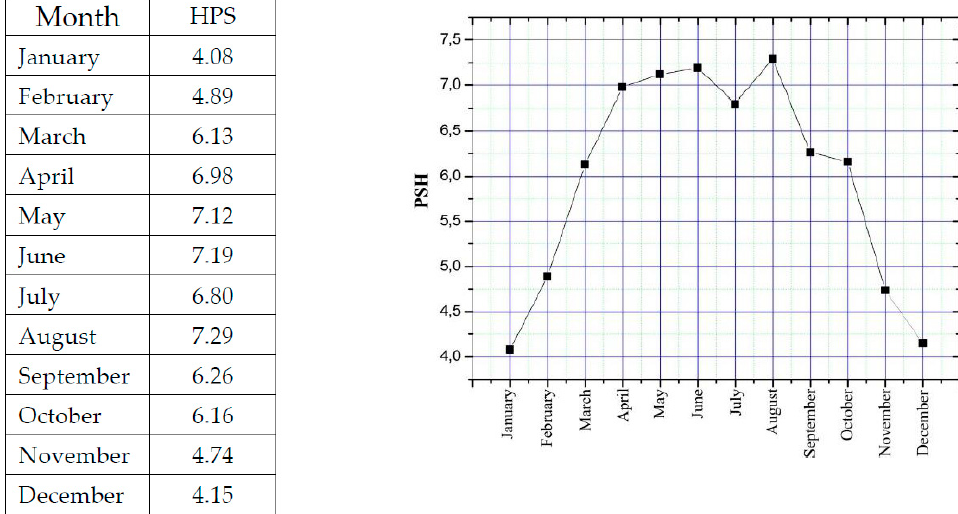
Figure 4. Average solar peak hours (PSH) for each month of the year (2010–2017).